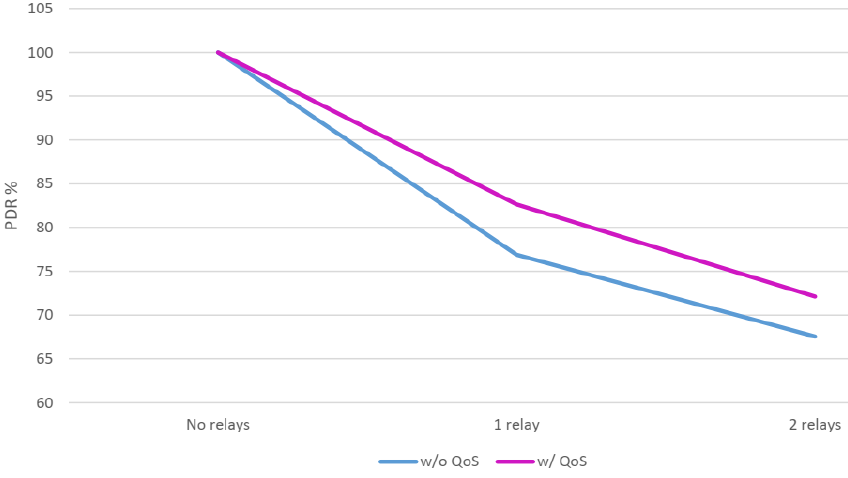
Figure 25. PDR with and without the application of backoff time as a QoS